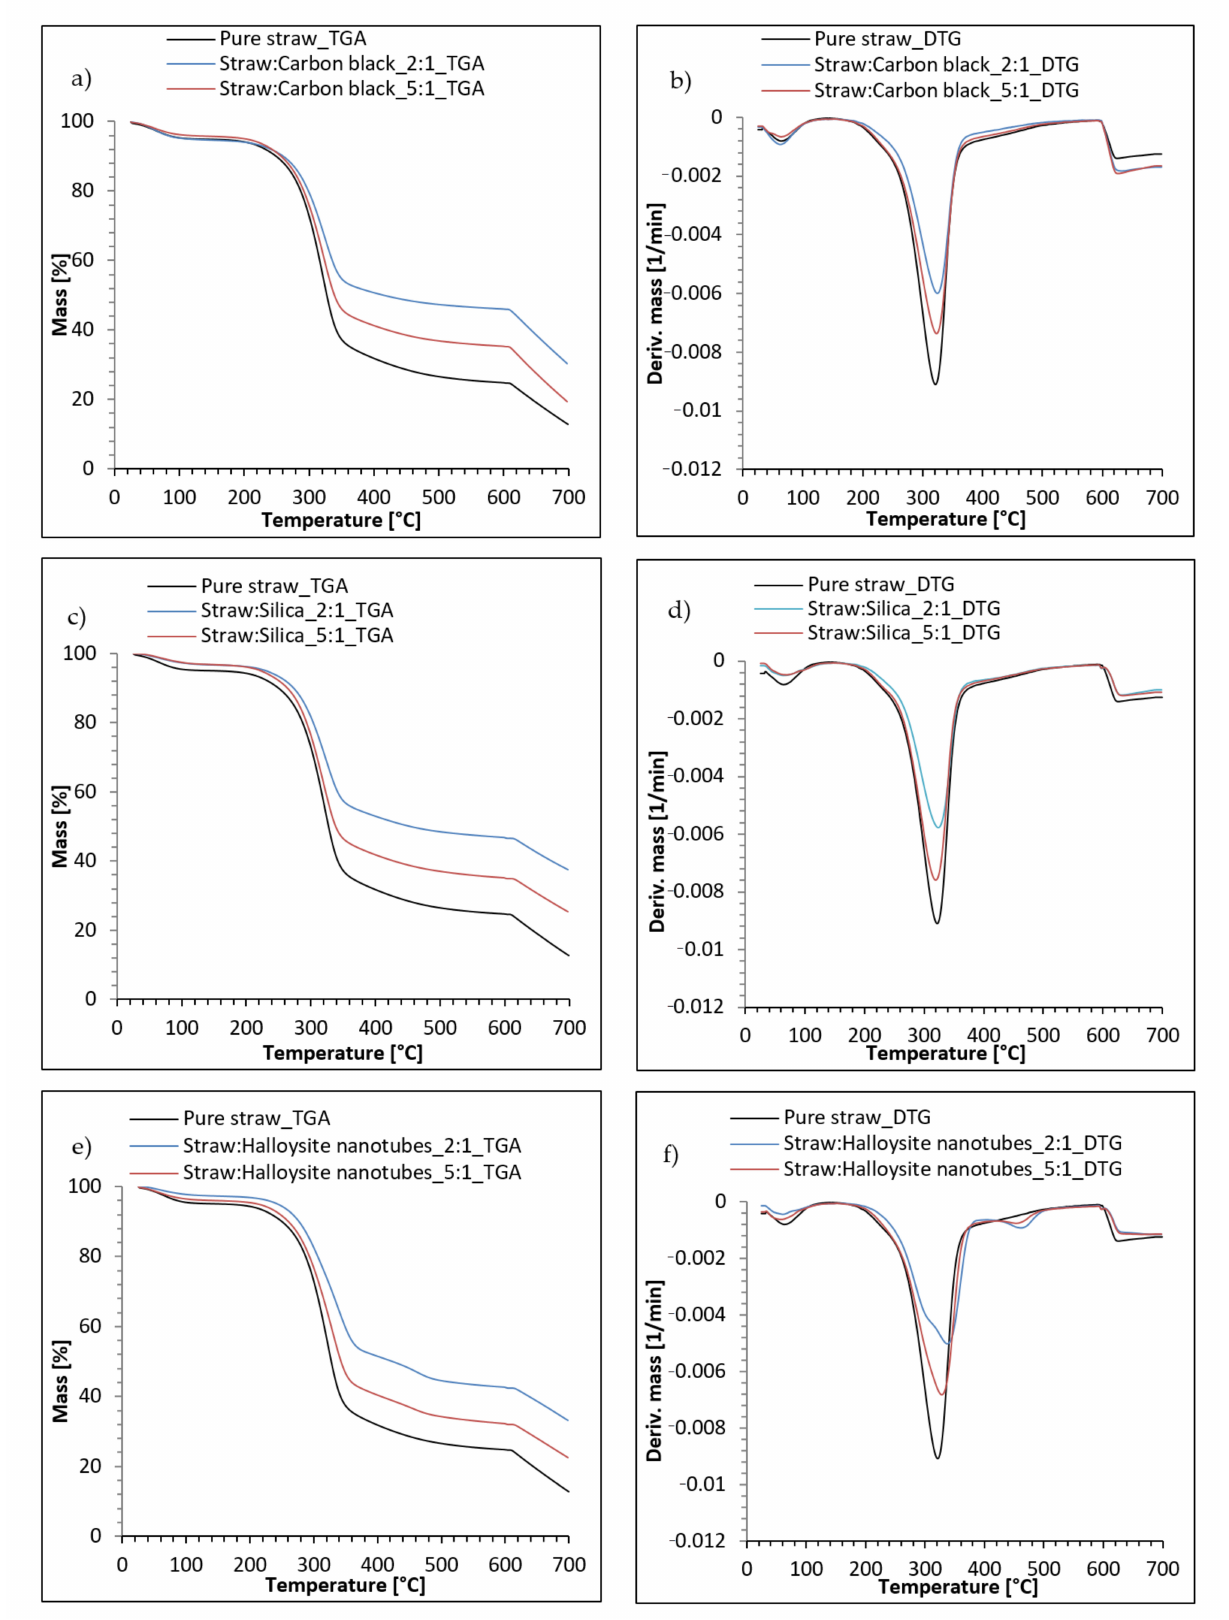
Figure 10. Thermal analysis of biofillers: ( a ) TG curve and ( b ) DTG curve for straw:carbon black; ( c ) TG curve and ( d ) DTG curve for straw:silica, ( e ) TG curve and ( f ) DTG curve for straw:halloysite